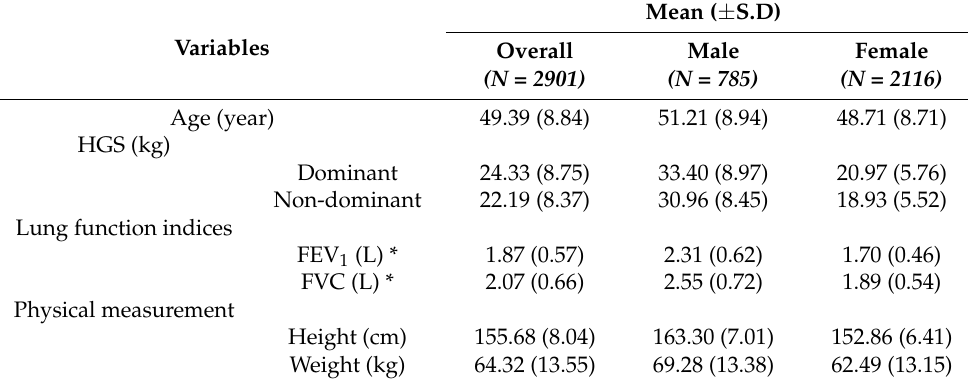
Table 1. Characteristics of the respondents.